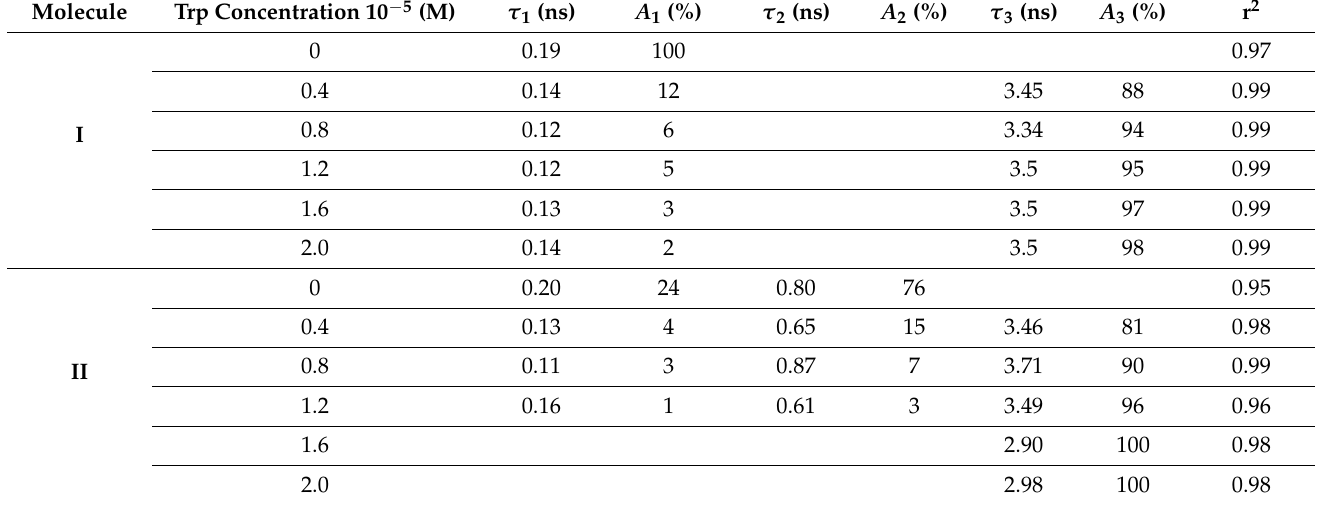
Figure 6. The long-wavelength absorption and fluorescence spectra ( λ exc. = 300 nm) of I ( A , A’ ) and II ( B , B’ ) (c = 5 × 10 − 5 M) in phosphate buffer solutions containing different concentration of Trp (0 M, 2.0 × 10 − 6 M, 4.0 × 10 − 6 M, 6.0 × 10 − 6 M, 8.0 × 10 − 6 M, 1.0 × 10 − 5 M, 1.2 × 10 − 5 M, 1.4 × 10 − 5 M, 1.6 × 10 − 5 M, 1.8 × 10 − 5 M, 2.0 × 10 − 5 M). In order to better visualize the changes in the absorption (in the long-wavelength (LW) region) and emission spectra, the normalized spectra (by scaling the area under the spectrum to be equal to unity) are presented in insert.